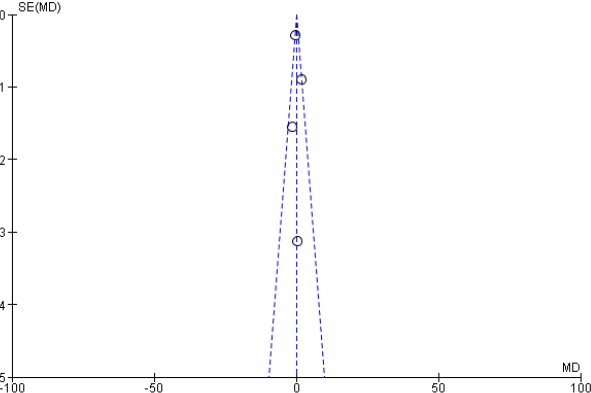
Figure 17. Funnel plot for maxillary expansion between experiment and control after removing the studies lies outside the funnel.